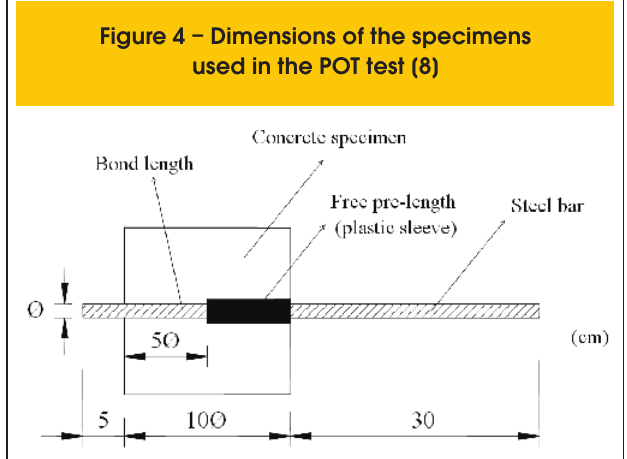
Figure 4 – Dimensions of the specimens used in the POT test